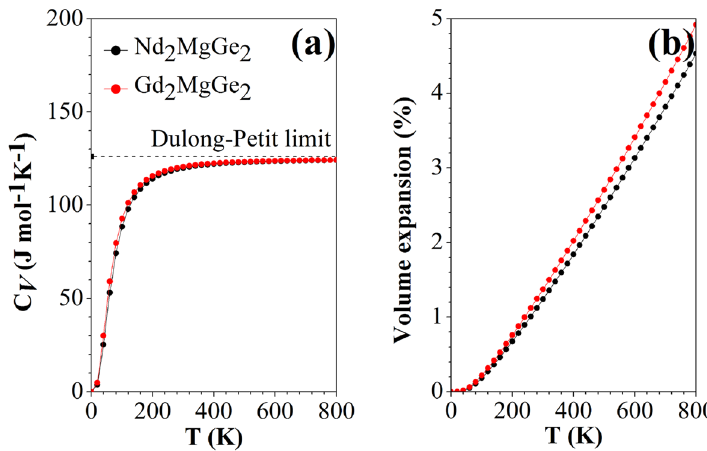
Figure 8. Temperature dependence of the ( a ) heat capacity and ( b ) volume expansion (unit